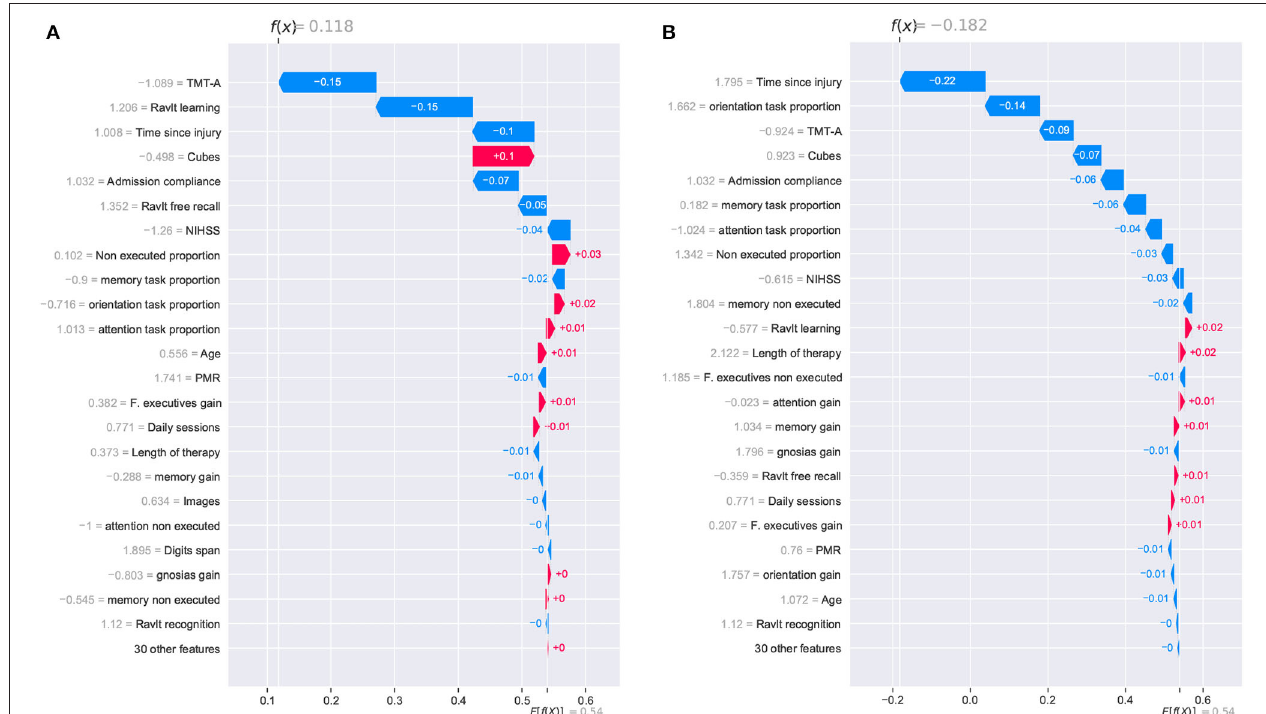
FIGURE 9 | SHAP waterfall plots for explanations of individual predictions. Illustrative cases of two patients with the lowest global improvement scores. Positive feature effects are represented in red and negative effects in blue. Plot should be read from E [ f ( x )], expected value of the model output, toward f ( x ), the model output. Negative outcomes in the x-axis (in log-odds units) are probabilities above 0.5 of classifying a patient as a no cognitive improvement case (class “0”). (A) Patient_27 and (B)